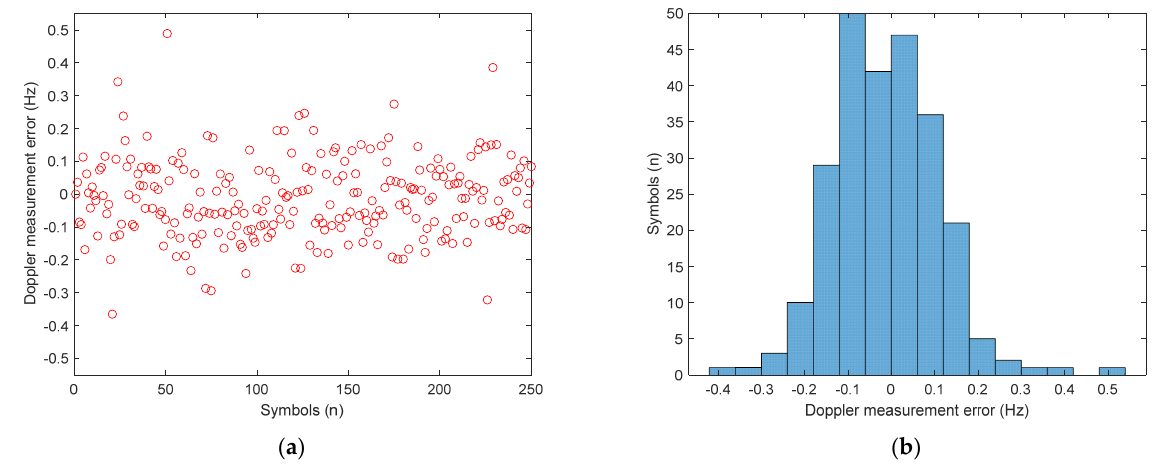
Figure 12. Comparison of the measured Doppler factor.